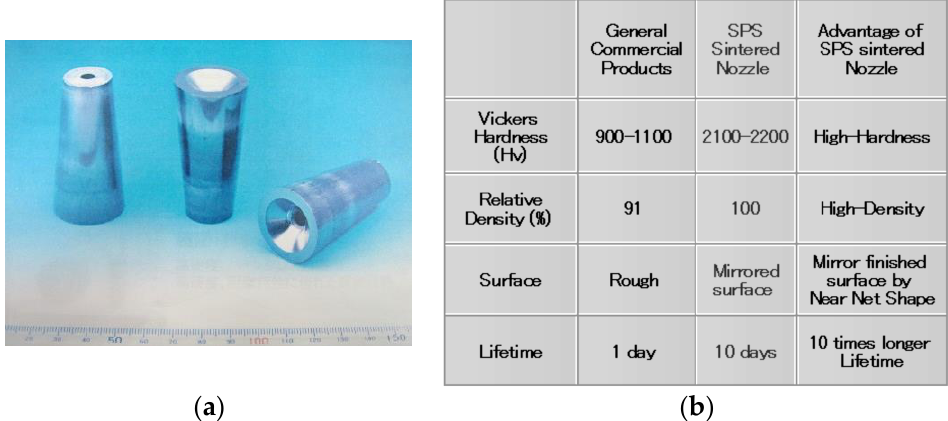
Figure 35. Comparison of SPSed blasting nozzle and other commercial nozzle products: (a) as-sintered SPSed nozzle prod- ucts: material: Al 2 O 3 , Length: 60 mm, Outer dia. (Tapered): 30/15 mm, Inner dia. (Straight): 6 mm; ( b ) Performance com- parison table of SPSed Al 2 O 3 nozzle and other commercial products